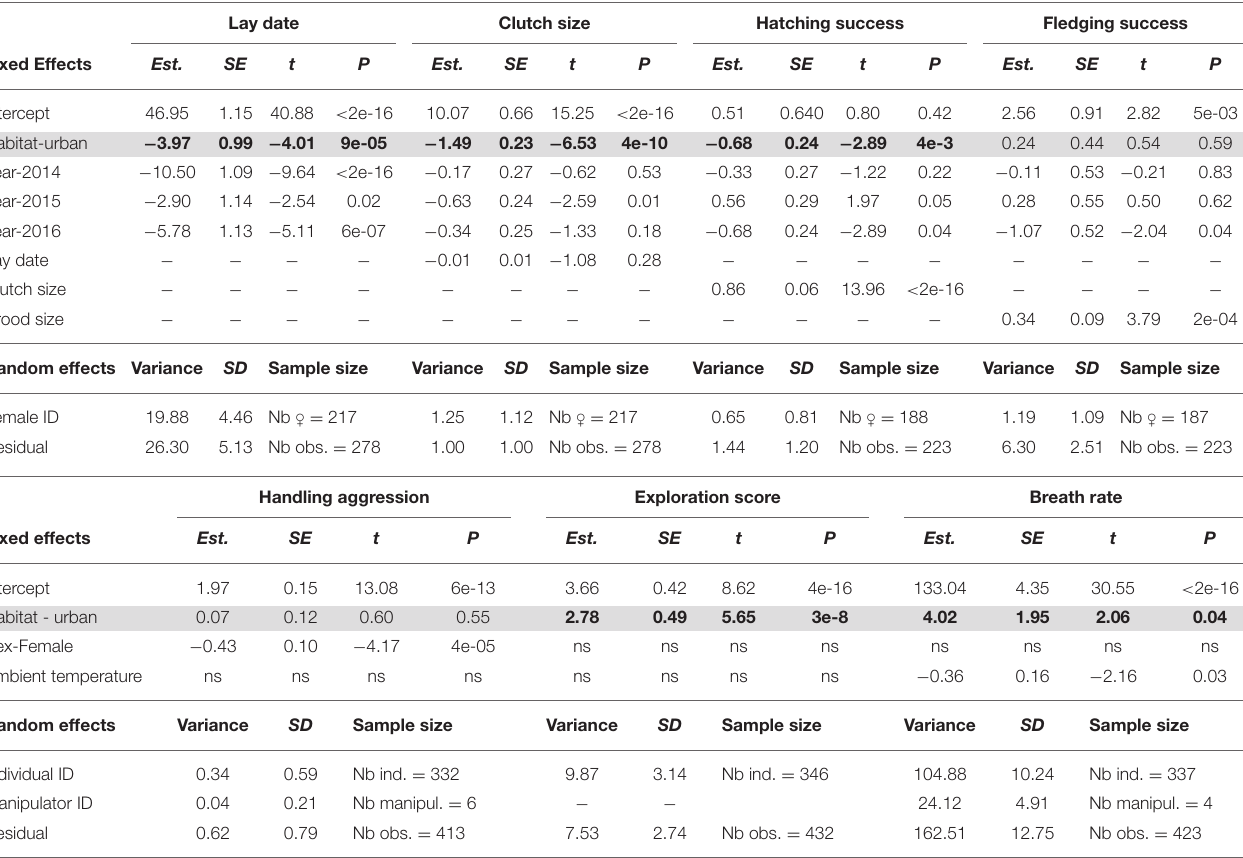
TABLE 3 | Contrasting phenology, reproductive success, behavior, and physiology between forest and city birds (Habitat) using linear mixed models with female/individual identity and manipulator identity (for handling aggression and breath rate) as random